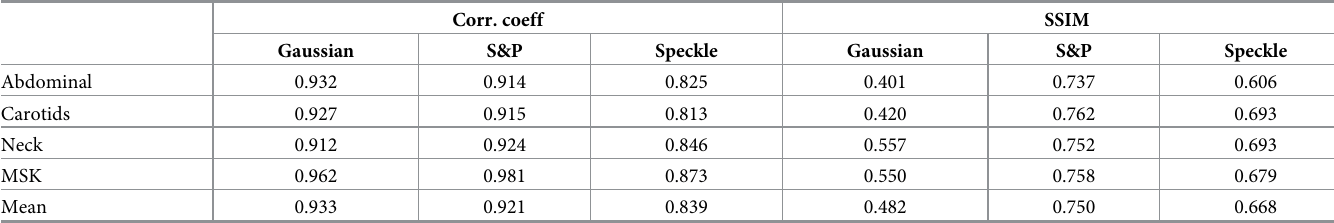
Table 3. Median comparison of SSIM and correlation coefficient for Db2 wavelet with decomposition level 3 and various noise levels and datasets. Corr. coeff SSIM Gaussian S&P Speckle Gaussian S&P Speckle Abdominal 0.932 0.914